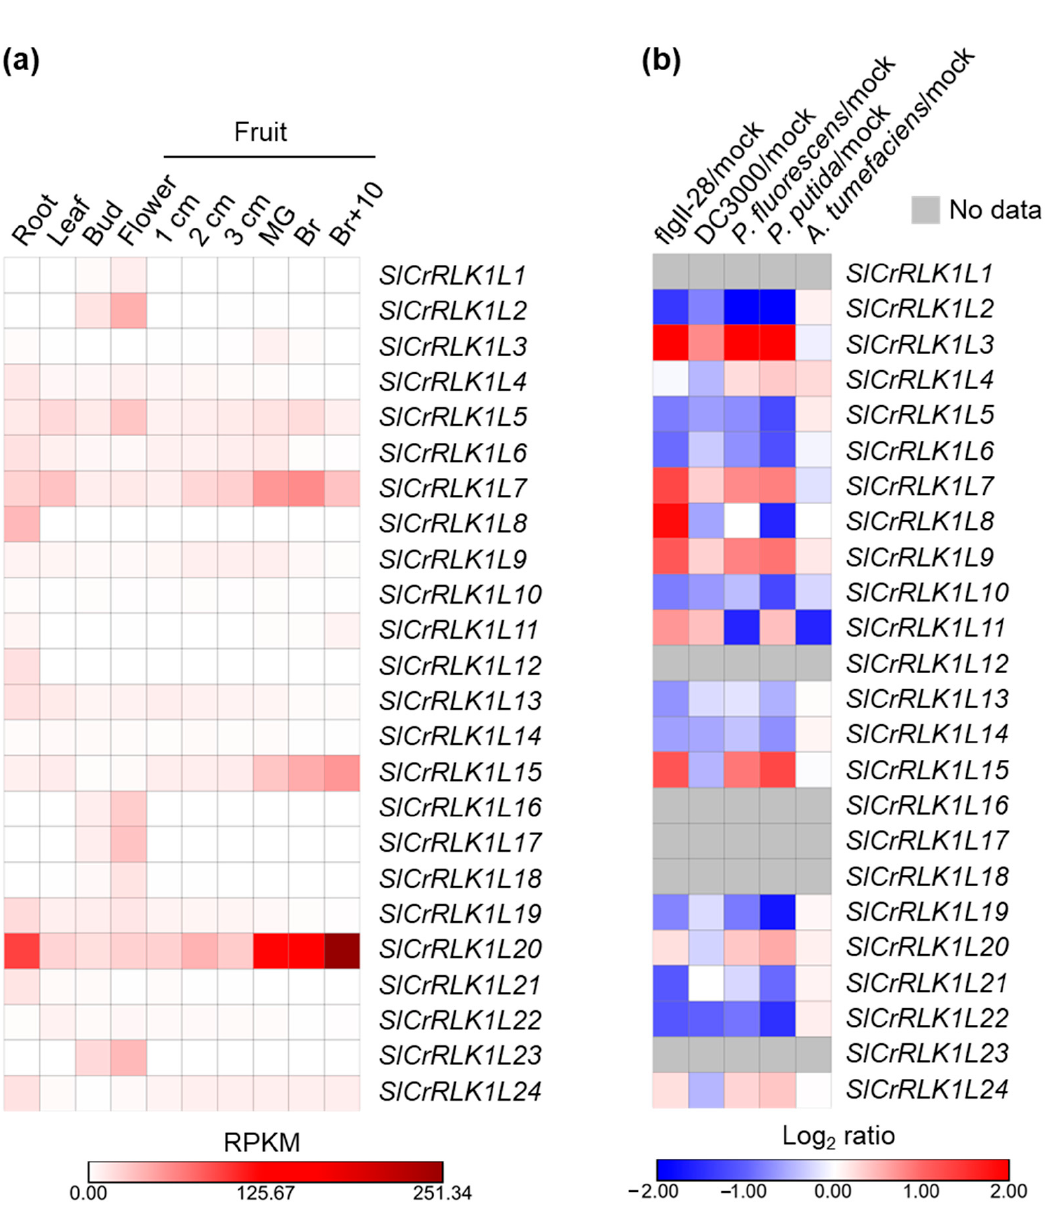
Figure 7. Expression pattern analysis of SlCrRLK1Ls . ( a ) Heatmap of SlCrRLK1L expressions in a variety of tissues. RPKM: reads per kilobase per million mapped reads. ( b ) Heatmap of SlCrRLK1L expressions in various bacteria and PAMP. No available data are represented by a gray color. All of the data were acquired from the SGN RNA-seq database.